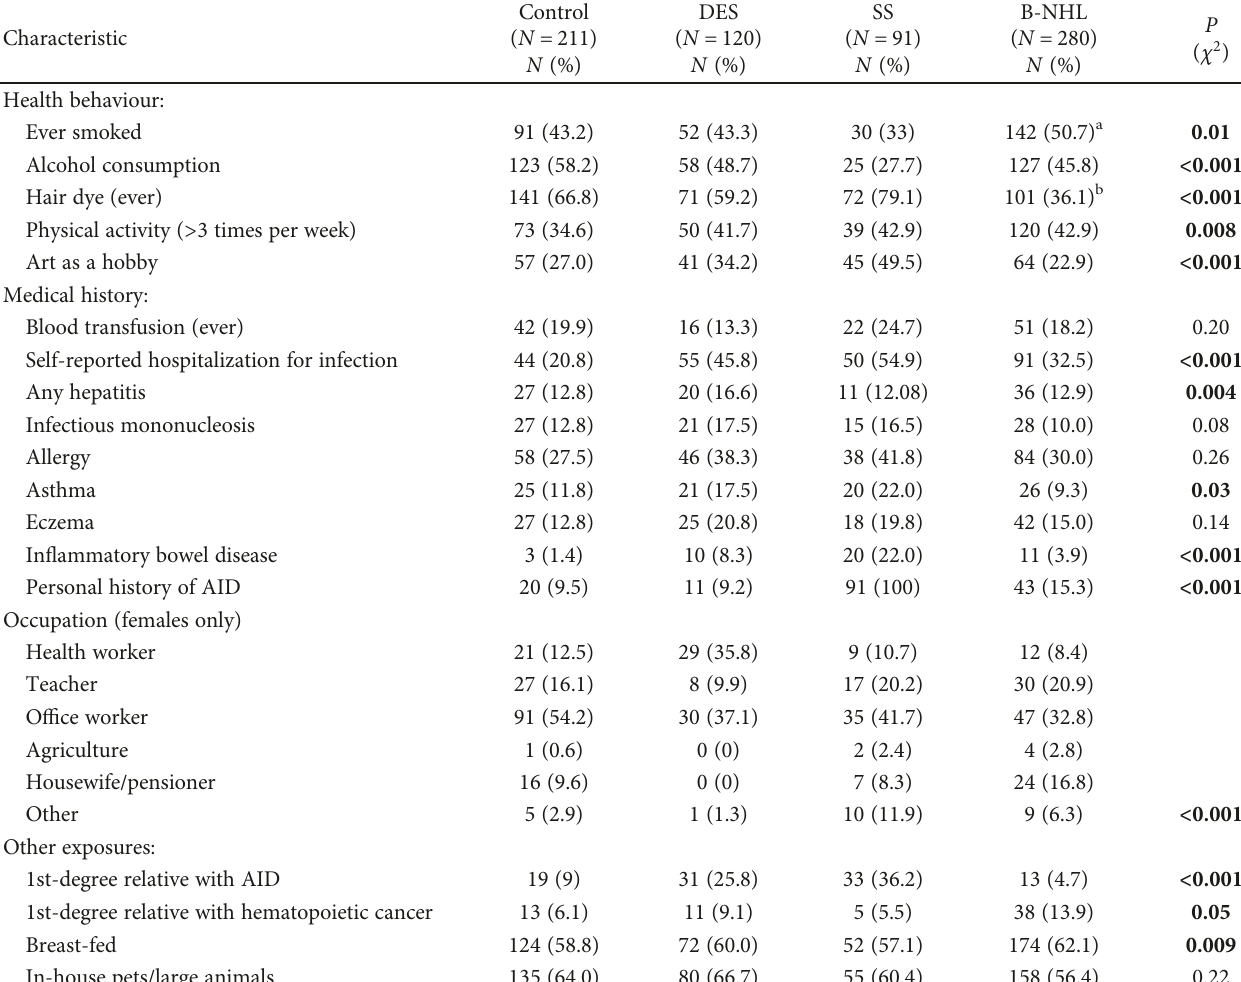
Table 2: Environmental exposures and medical history of study population-unadjusted analysis.